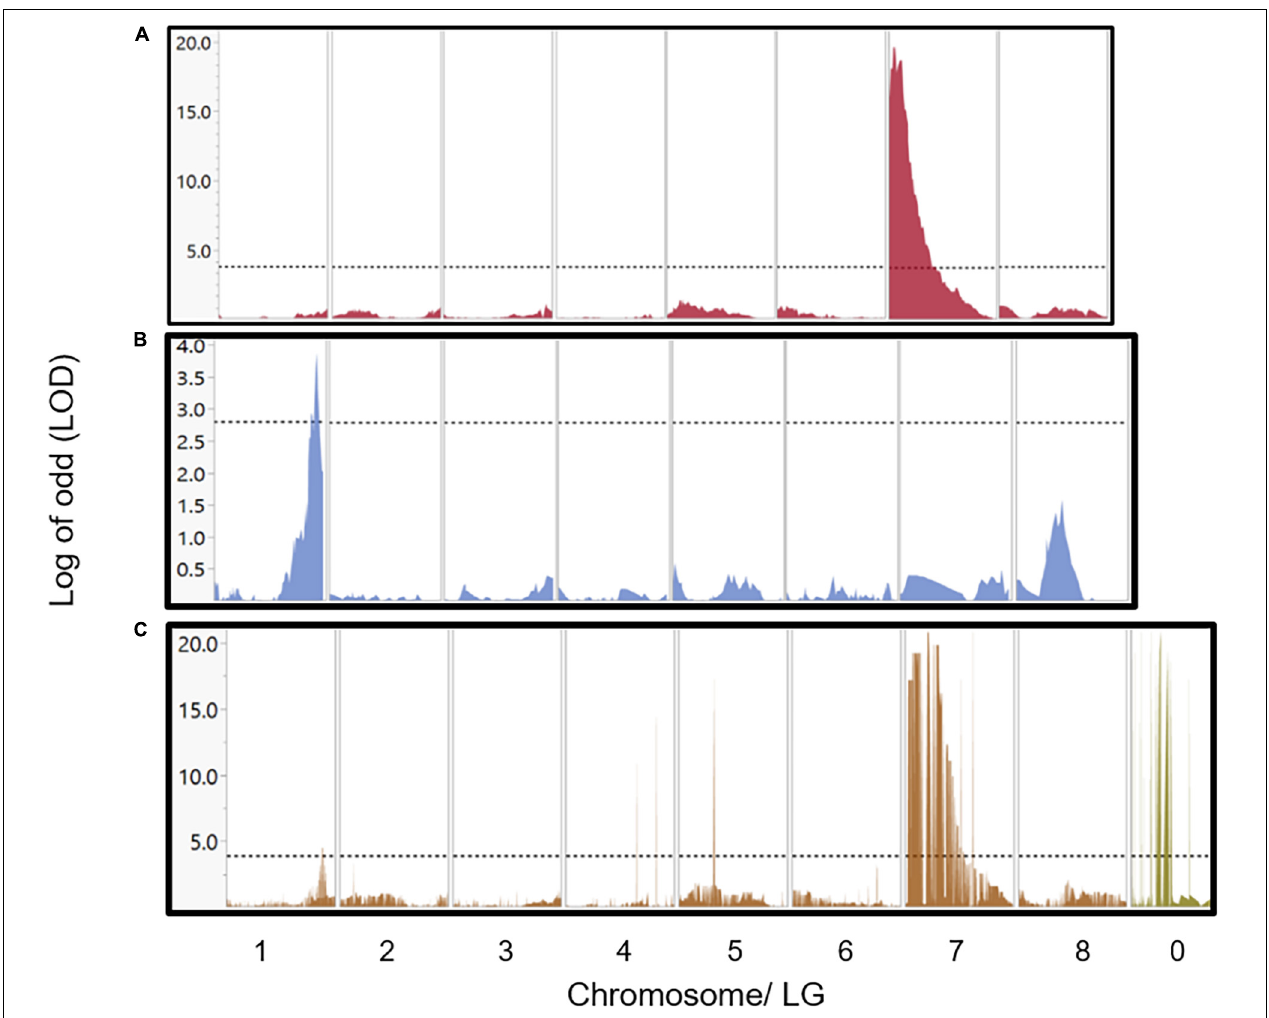
FIGURE 6 | QTLs and GWAS analysis for the SPC trait. Major QTL of 2.4 cm width and LOD score of 20.8 was detected in chromosome 7 by using the U.E.F. genetic map (A) . Minor QTL of 4.4 cm width and LOD score (3.9) was located at the end of chromosome 1 by using the P. arabica genetic map (B) . Results of GWAS using the whole set of markers (3,800) sorted by their physical position according to the reference genome (C) , revealed both loci in chromosome 7 and chromosome 1. Markers in c were sorted by their physical position according to the reference genome. Markers that were placed on chromosome 0 and found as highly associated with the SPC trait are also shown in (C) . The horizontal dash line represents the significance level according to permutation test (1,000 times at α =